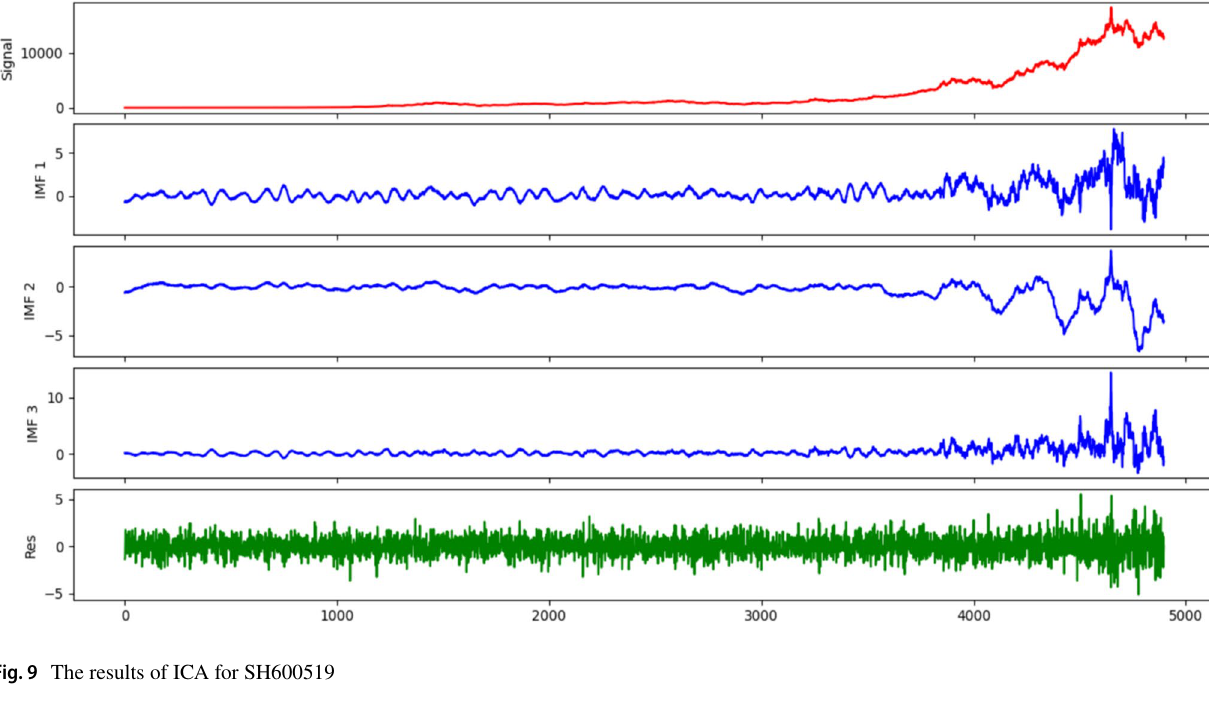
Fig. 9 The results of ICA for SH600519